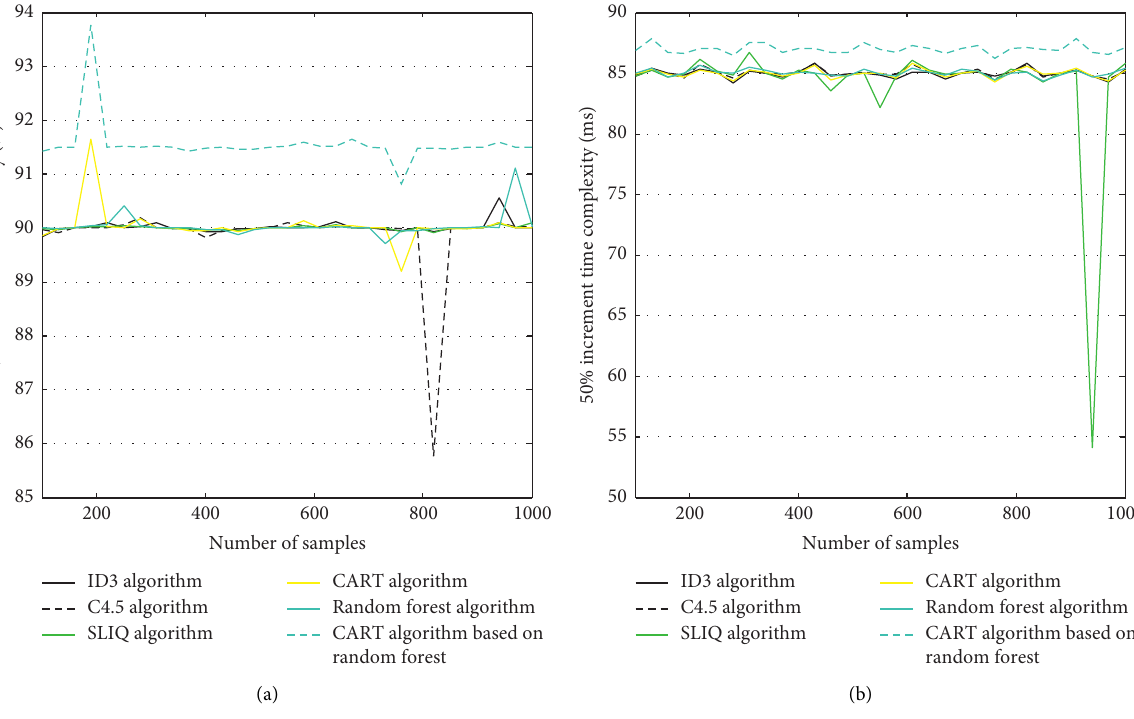
Figure 5: Comparison of two algorithm tests with an increment of 50%. (a) Comparison of test accuracy of two algorithms with 50% increment. (b) Comparison of time complexity of two algorithms with 50%